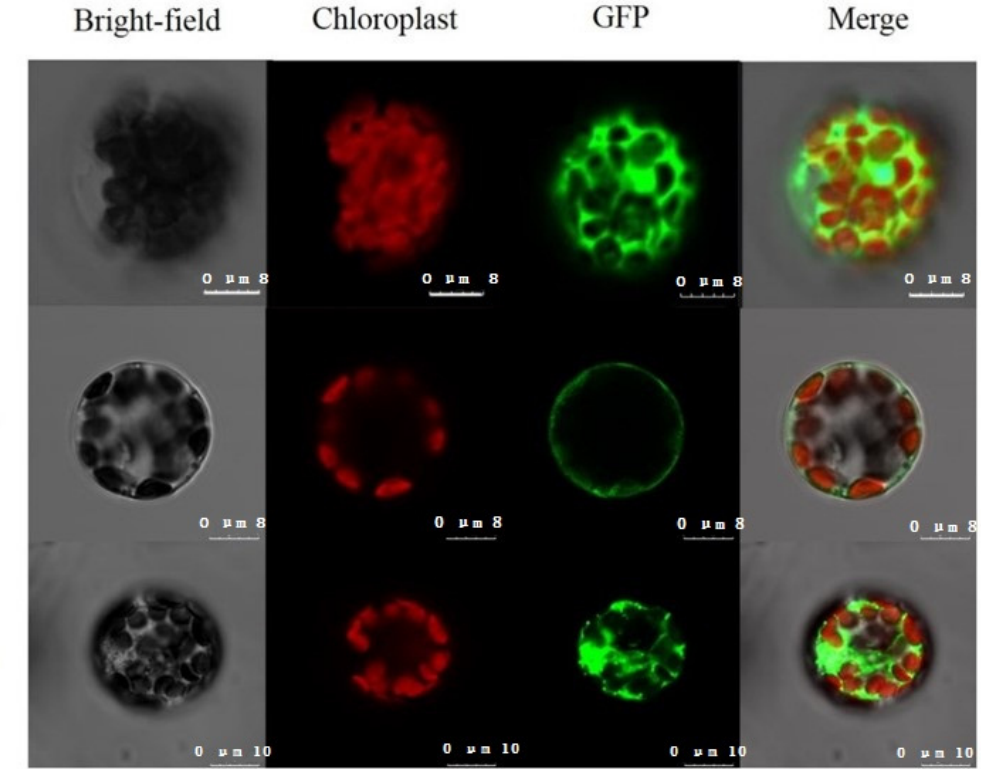
Figure 2. Subcellular localization of MsRCI2D/-E–GFP in Arabidopsis protoplasts. Confocal laser scanning microscope images of Arabidopsis protoplasts expressing GFP fused to MsRCI2D,-E proteins. The red fluorescence signal represents FM4-64-stained chloroplast in a cell. The white scale bars represent 8 or 10 µm.